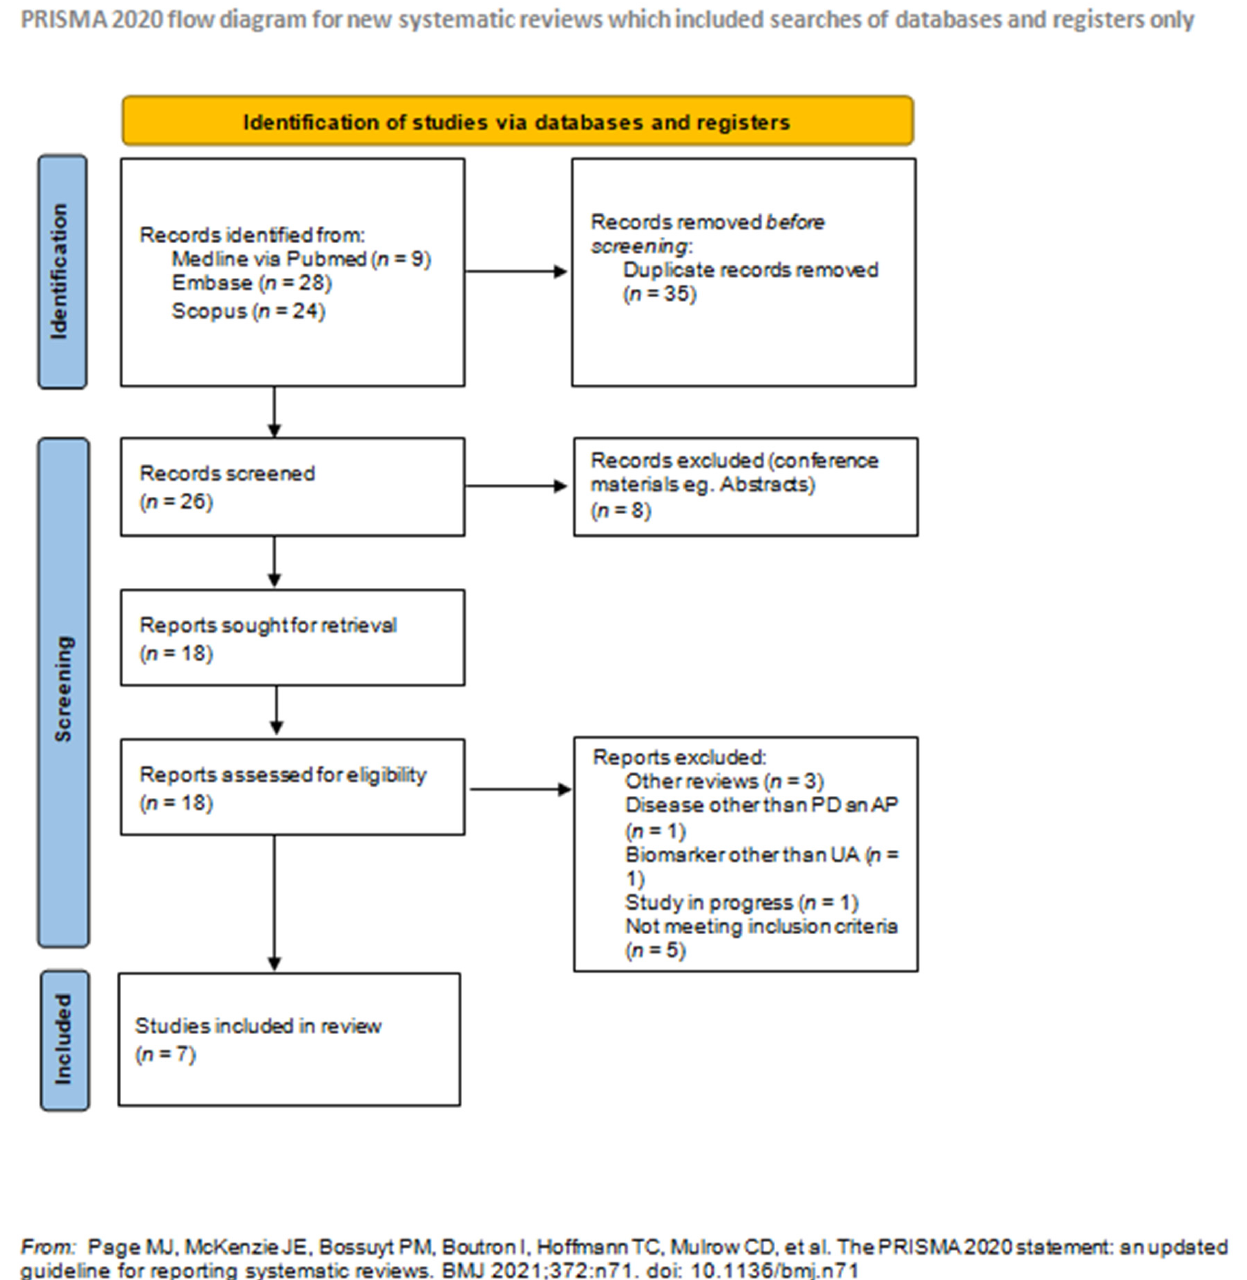
Figure 1. PRISMA flow diagram. For more information, visit: http://www.prisma-statement.org/ (accessed on 15 September